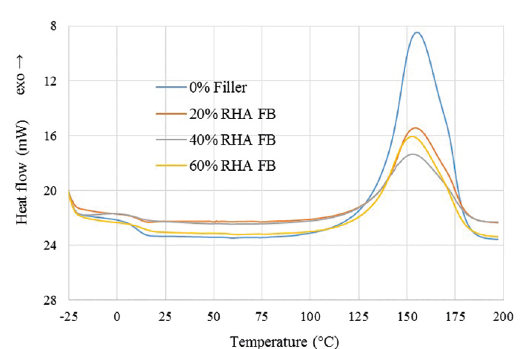
Figure 7. DSC of the composites prepared with 20, 40, and 60% (wt) RHA-FB